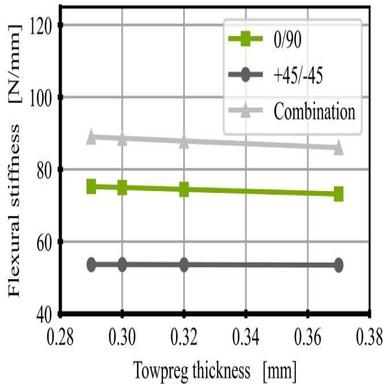
Correlation between analytically modelled flexural stiffness of 2D plate and varied towpreg thickness.